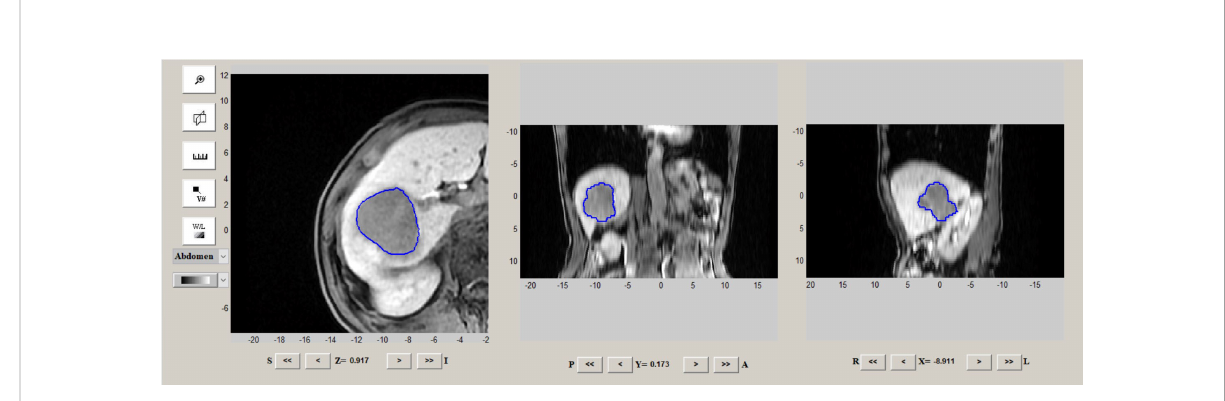
FIGURE 1 Example of ROIs delineation on HBP 15 min images by IBEX